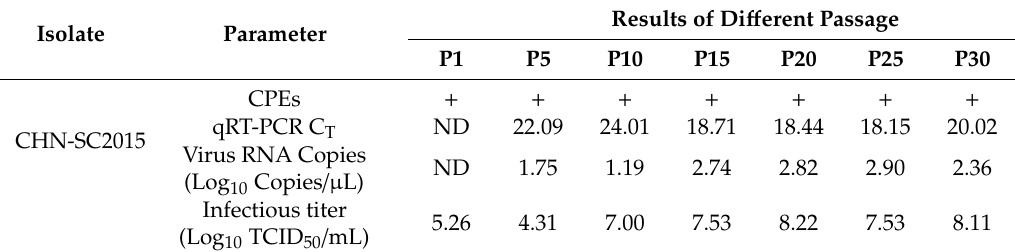
Table 1. Replication of early and late passages of PDCoV strain CHN-SC2015.